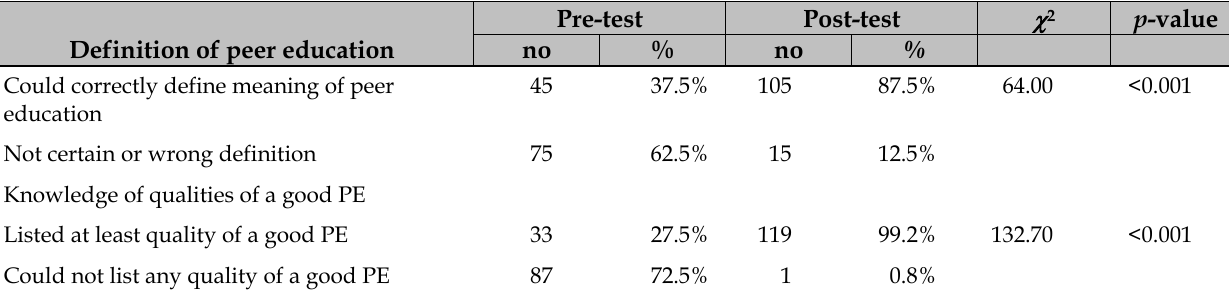
Table 4 Summary of PE activities by gender and type of school